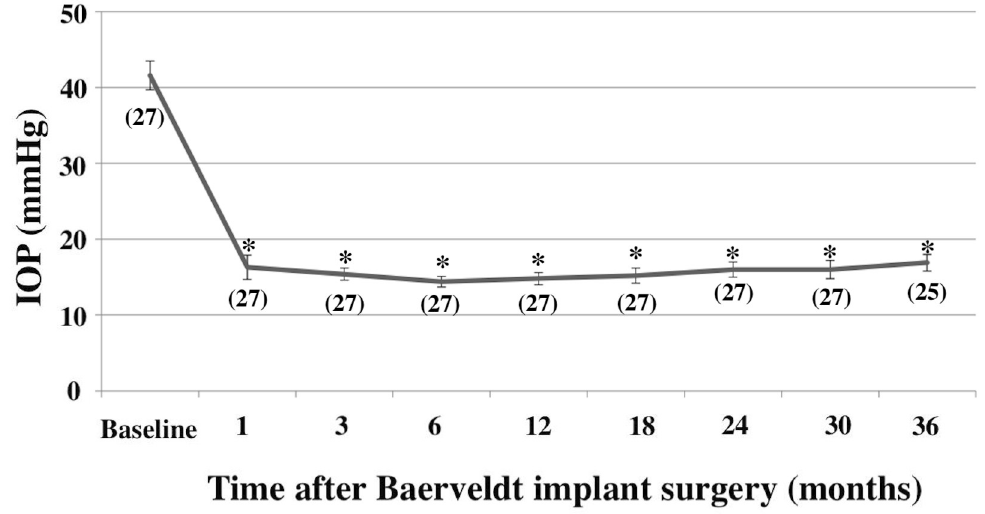
Fig 2. Postoperative intraocular pressure course after Baerveldt implant surgery. The mean intraocular pressures (IOP) ± standard error of the mean ( ± SEM) during the preoperative and 1-, 3-, 6-, 12-, 18-, 24-, 30-, and 36-month postoperative periods after Baerveldt implant surgery are shown. � P < 0.001, compared with the preoperative mean IOP based on the analysis of variance with Bonferroni correction. The number of eyes at each time point is shown in parentheses.